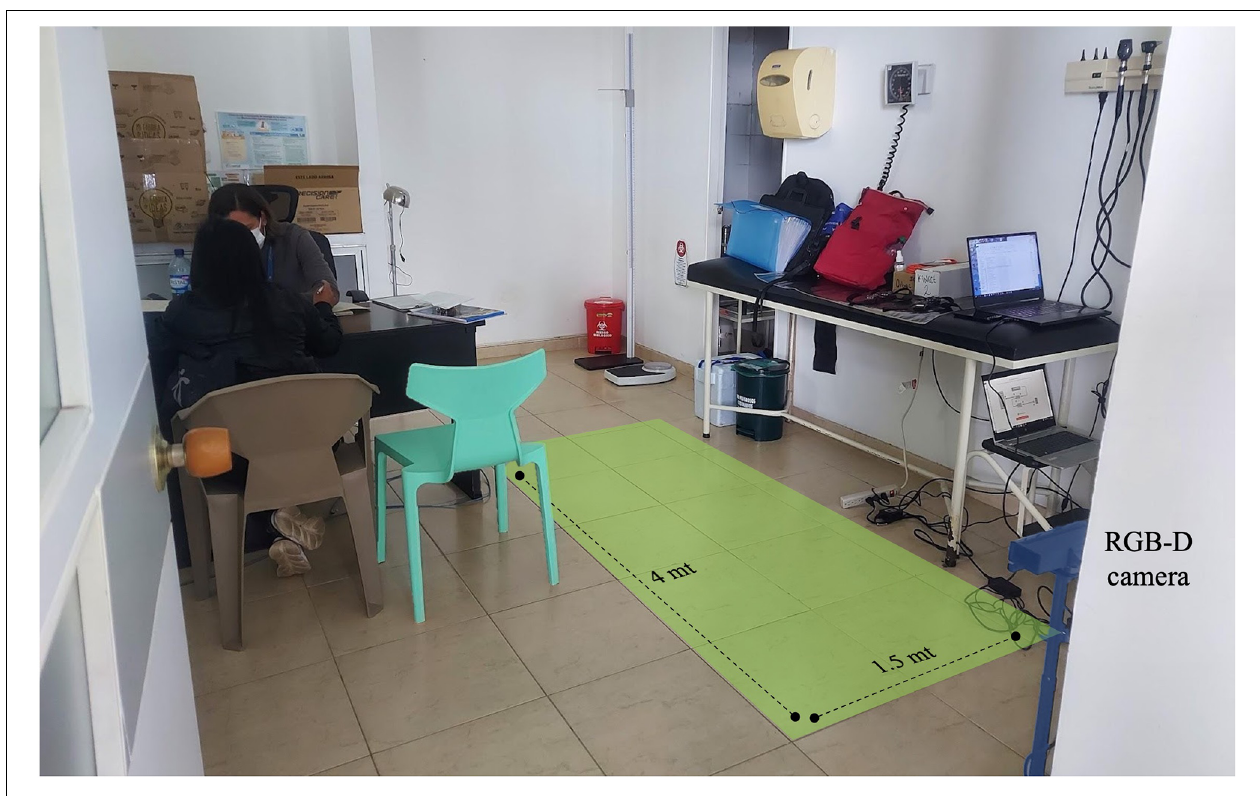
FIGURE 1 | RGB-D camera setup and gait evaluation